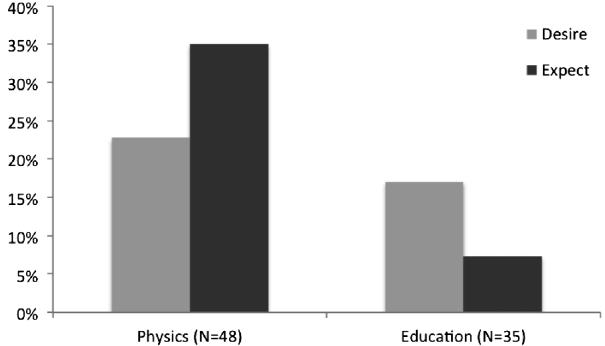
FIG. 8. Average age of PER graduate students who report being unsure of where they expect to be working and those who expect to have a tenure track position in a research intensive university (with error bars representing the standard error of the mean).